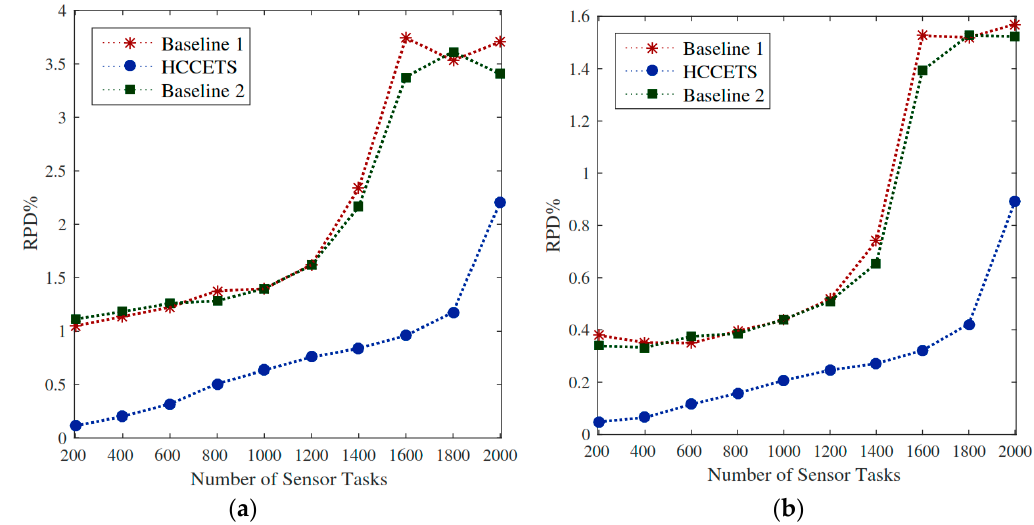
Figure 7. Objective function With deadline constraint. ( a , b ) the relative percentage ratio of the objective function.